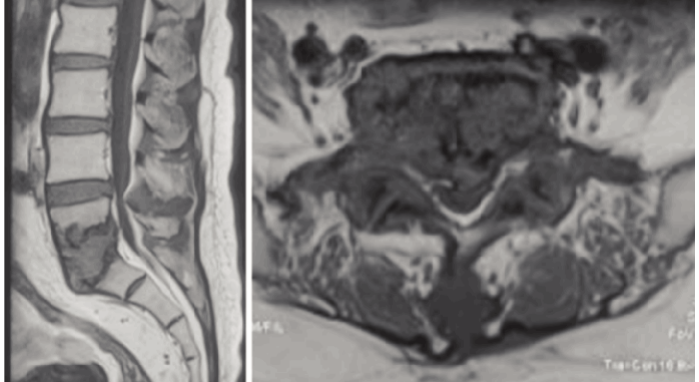
Magnetic resonance imaging (MRI) T1 weighted of sagittal and axial views which showed irregular inferior end plate L5 and Fig. 1: superior end plate S1, expanded.